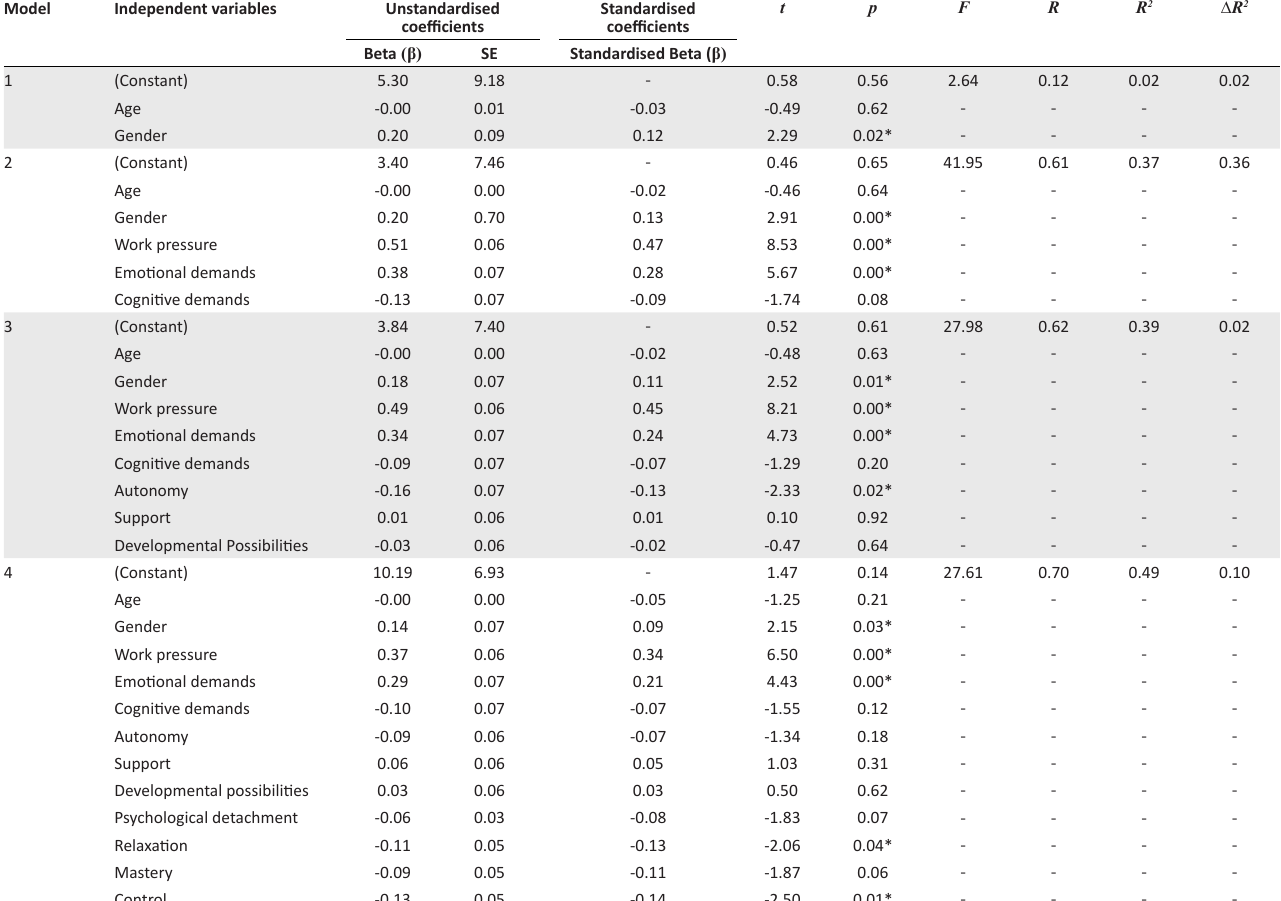
TABLE 4: Multiple regression analysis with work-domestic interference as dependent variable.